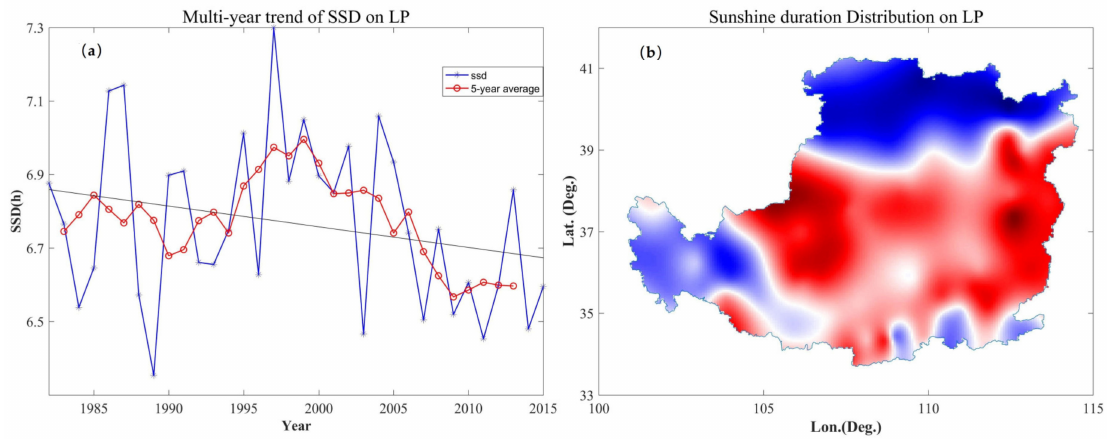
Figure 6. Time series of the average SSD ( a ) and spatial distribution over the Loess Plateau region ( b ).